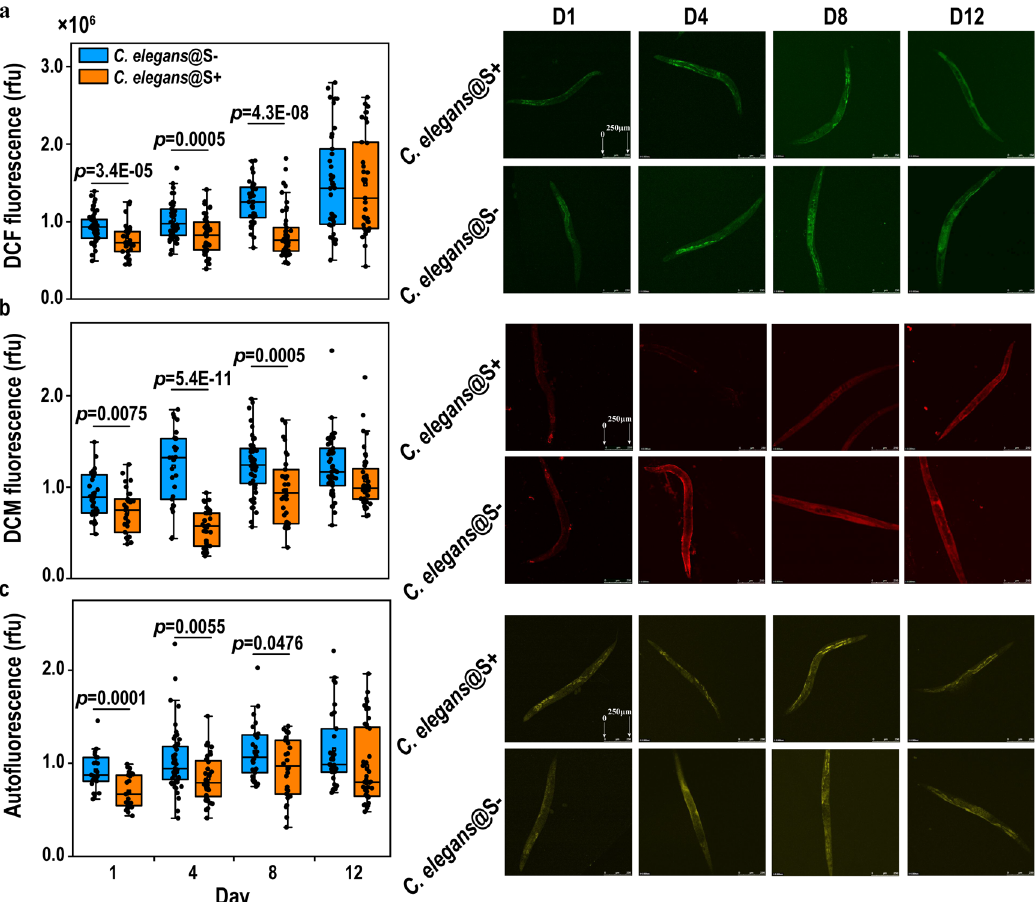
Fig. 1 The ROS level and lipofuscin accumulation of Caenorhabditis elegans fed Dnd + (S + ) and Dnd- (S-) OP50. a ROS level measured by the fl uorescent probe H fl uorescent probe DCM 2 DCF-DA (excitation, 488 nm; emission 550-600 nm, n S + > 35, n S- > 36); b ROS level measured by the (excitation, 478 nm; emission 550-600 nm, n S + > 28, n S- > 27); and c ) Auto fl uorescence of lipofuscin (excitation, 478 nm; emission 630 – 700 nm, n S + > 24, n S- > 26). C. elegans samples were collected on Day 1, 4, 8, and 12, after L4 larva-to-adult molts at 22 o C, the images with fl uorescence close to average reads were selected as examples in Fig. 1. Central lines represent the mean values, and error bars note the standard deviation (rfu, relative fl uorescence units. Statistical signi fi cance was calculated with two-tailed t-test and p values are indicated. see the details in Supplementary Figs. 1 –